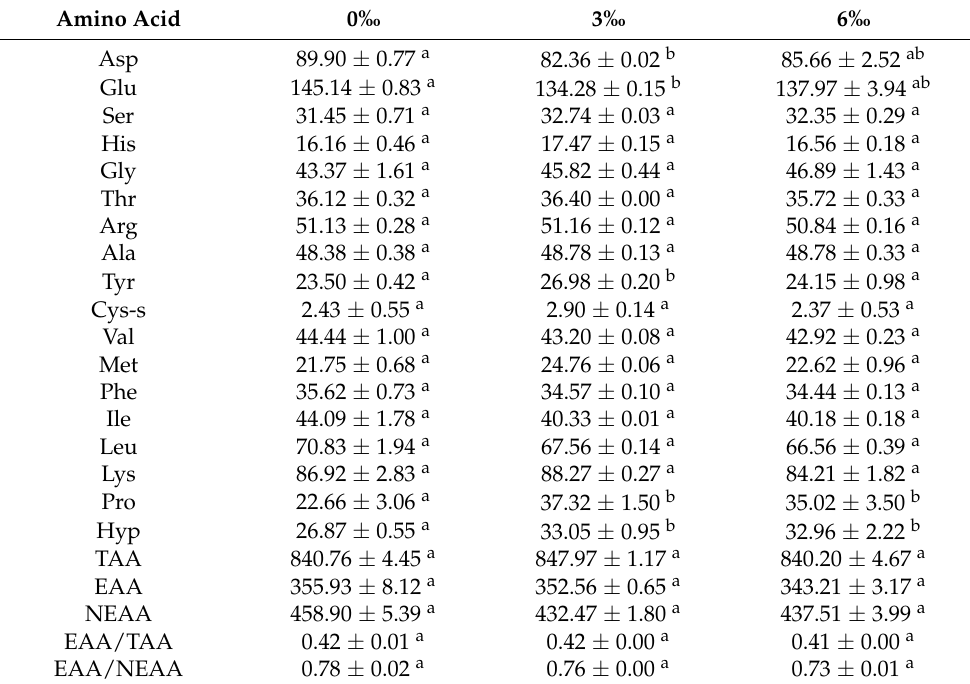
Table 1. Amino-acid composition of muscle in grass carp cultured at different salinities (mg/g dry weight basis).